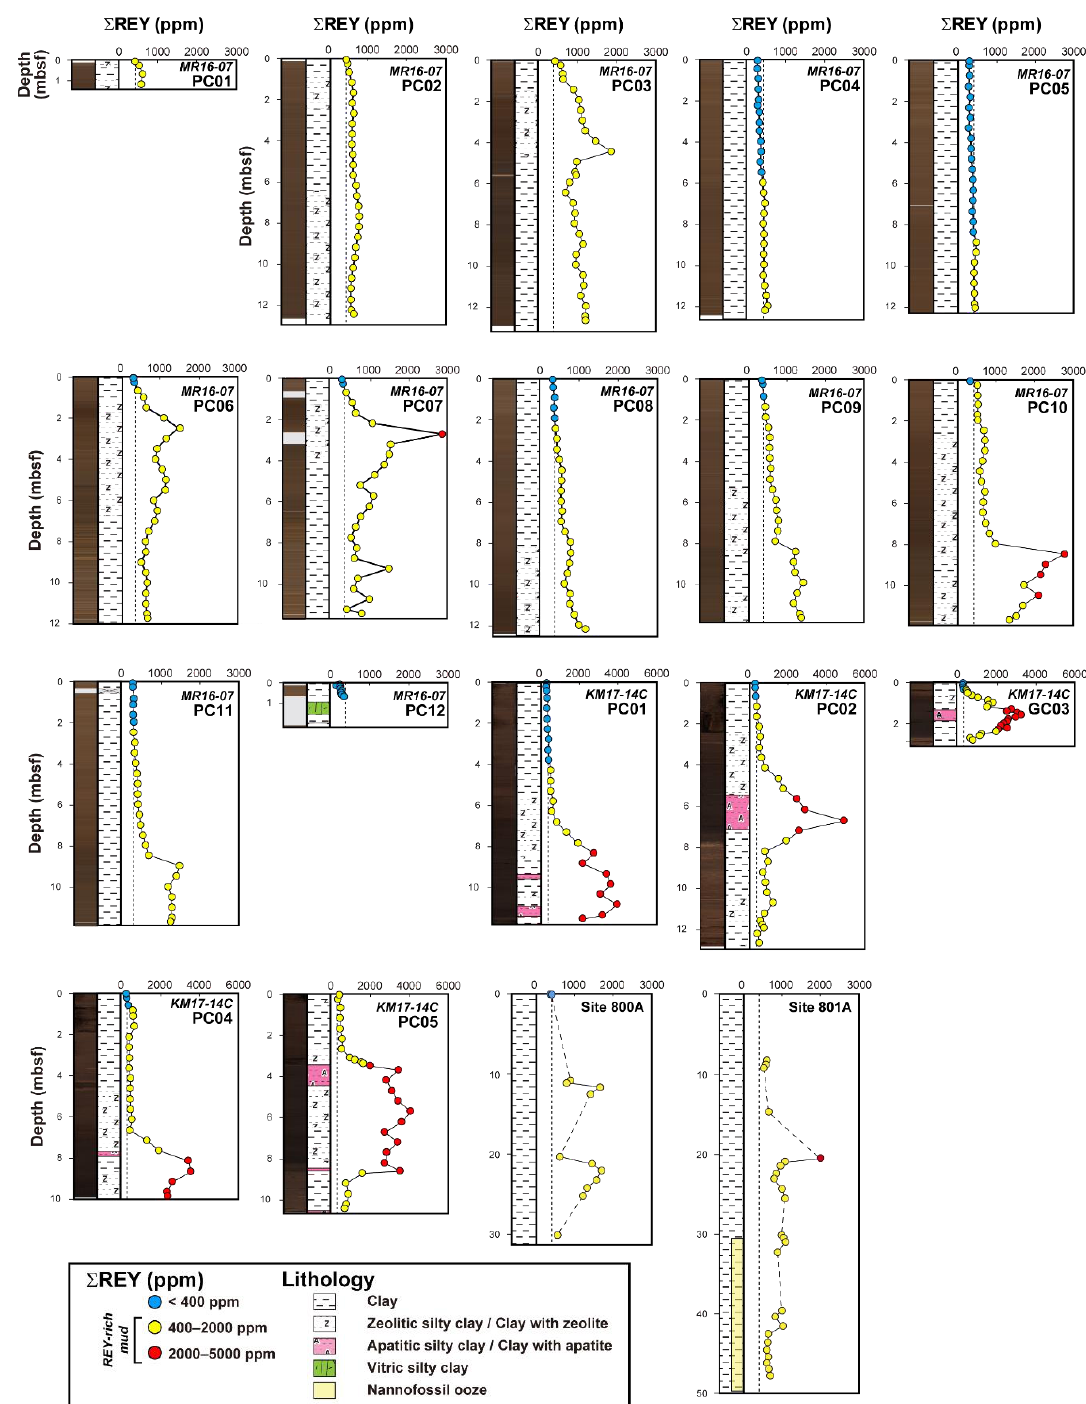
Figure 2. Depth profiles of color, lithology, and total rare-earth elements and yttrium (ΣREY) concentrations of sediment cores collected during Cruises MR16-07 and KM17-14C. The data of ODP Sites 800A and 801A are from Yasukawa et al. (2016) [5].